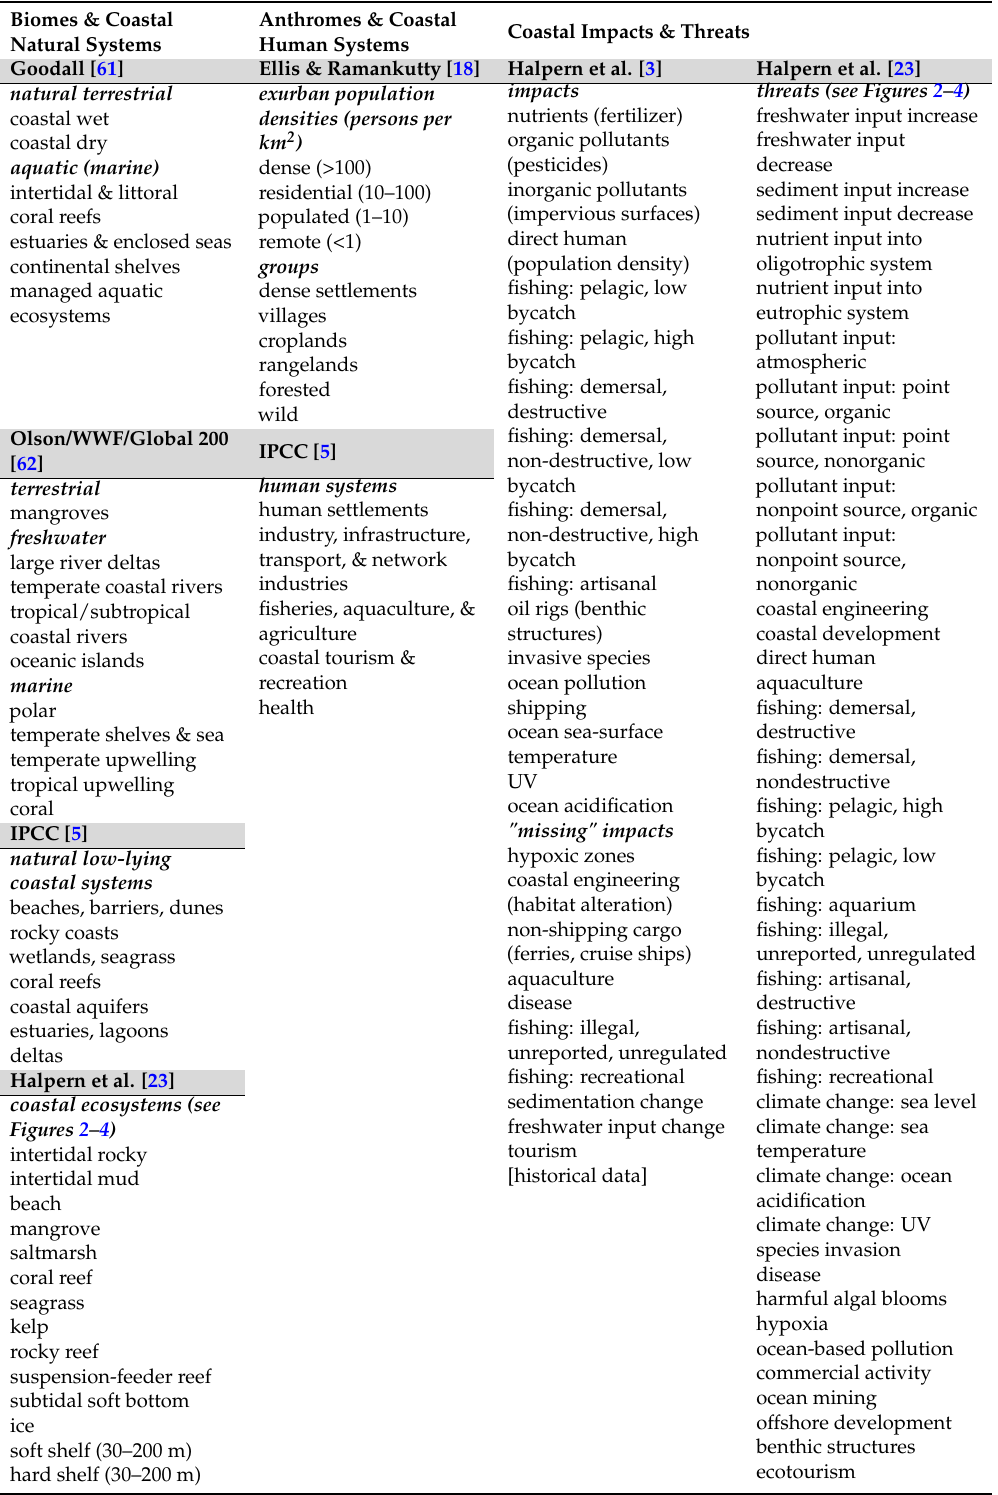
Table 1. Existing coastal biome/ecosystem classes, terrestrial anthrome groups, and coastal/marine stressors/impacts useful for informing an integrated coastal anthrome classification